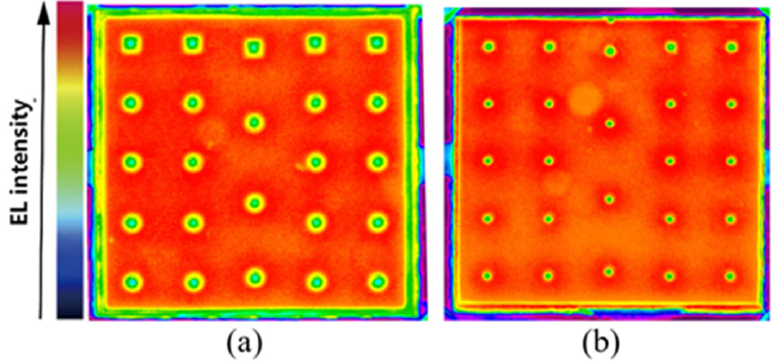
Figure 4. ( a ) Light emission distributions in the normal Ag-based FCLED. ( b ) Light emission intensity distributions in the CRS-FCLED.